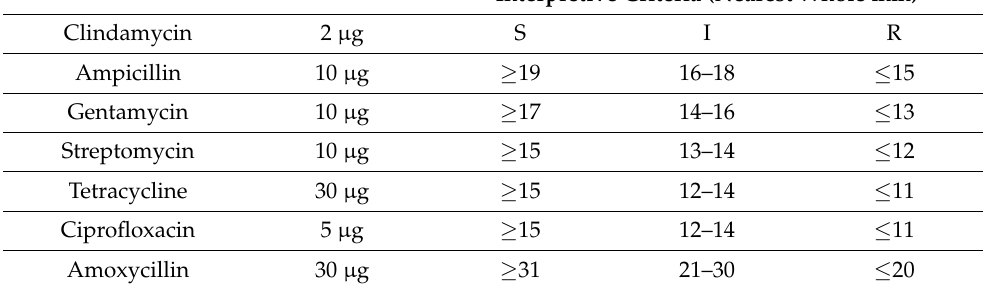
Table 10. Interpretation criteria. Antimicrobial Agent Disk